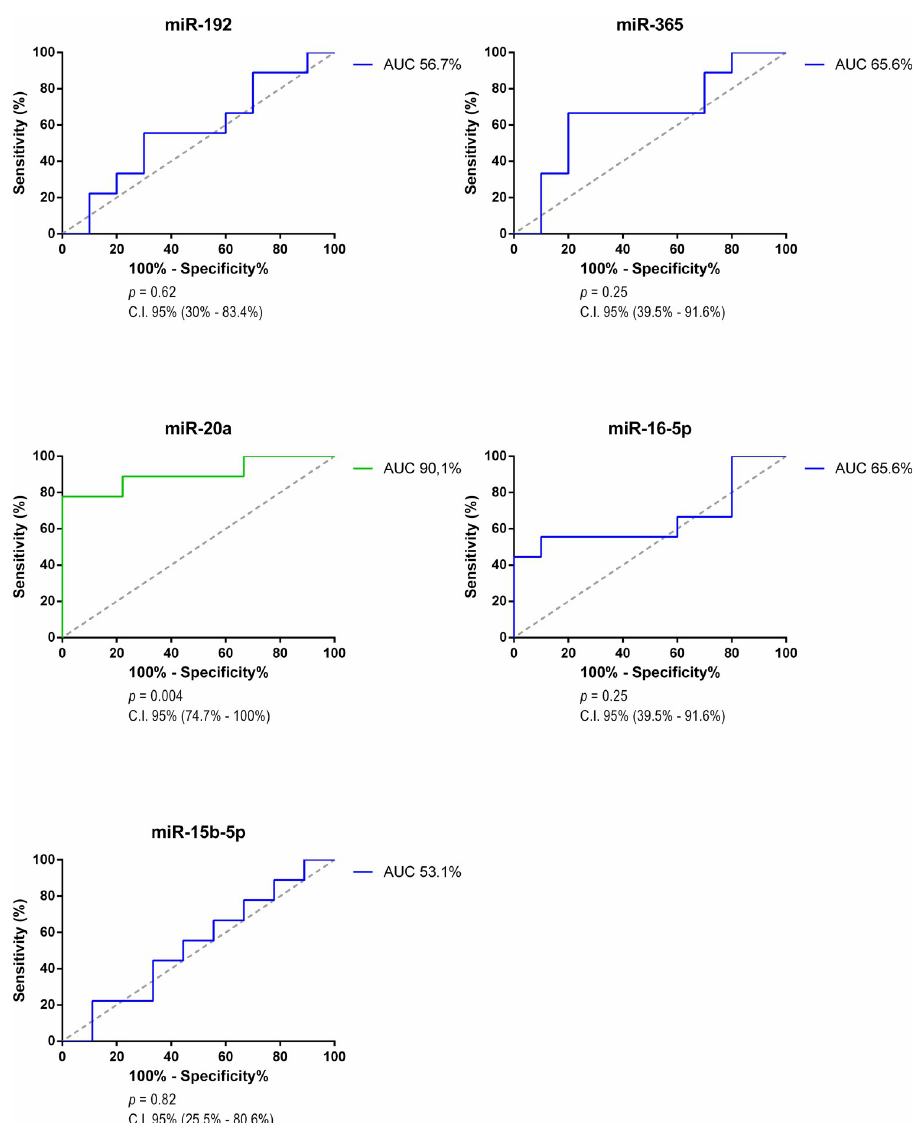
Fig 4. ROC curve of serum microRNAs (Control x